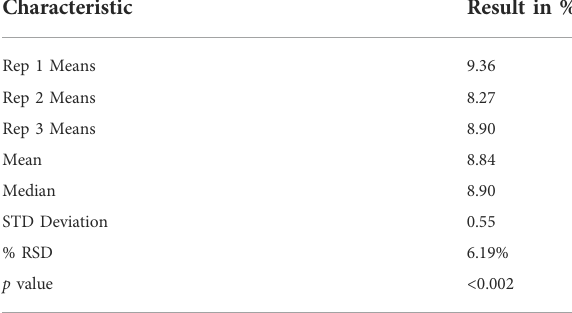
TABLE 1 Milled Cannabis fl ower potency